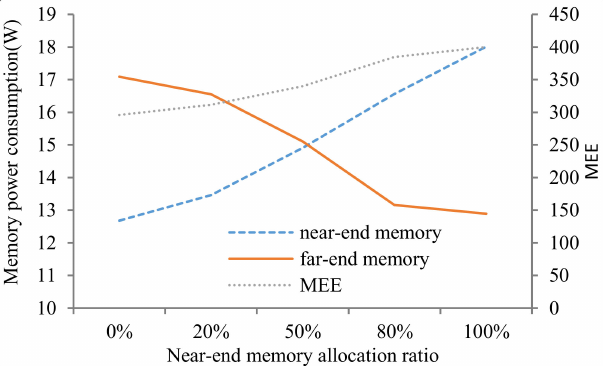
Figure 16. Experiment of singe thread STREAM array size of 128 G under NUMA